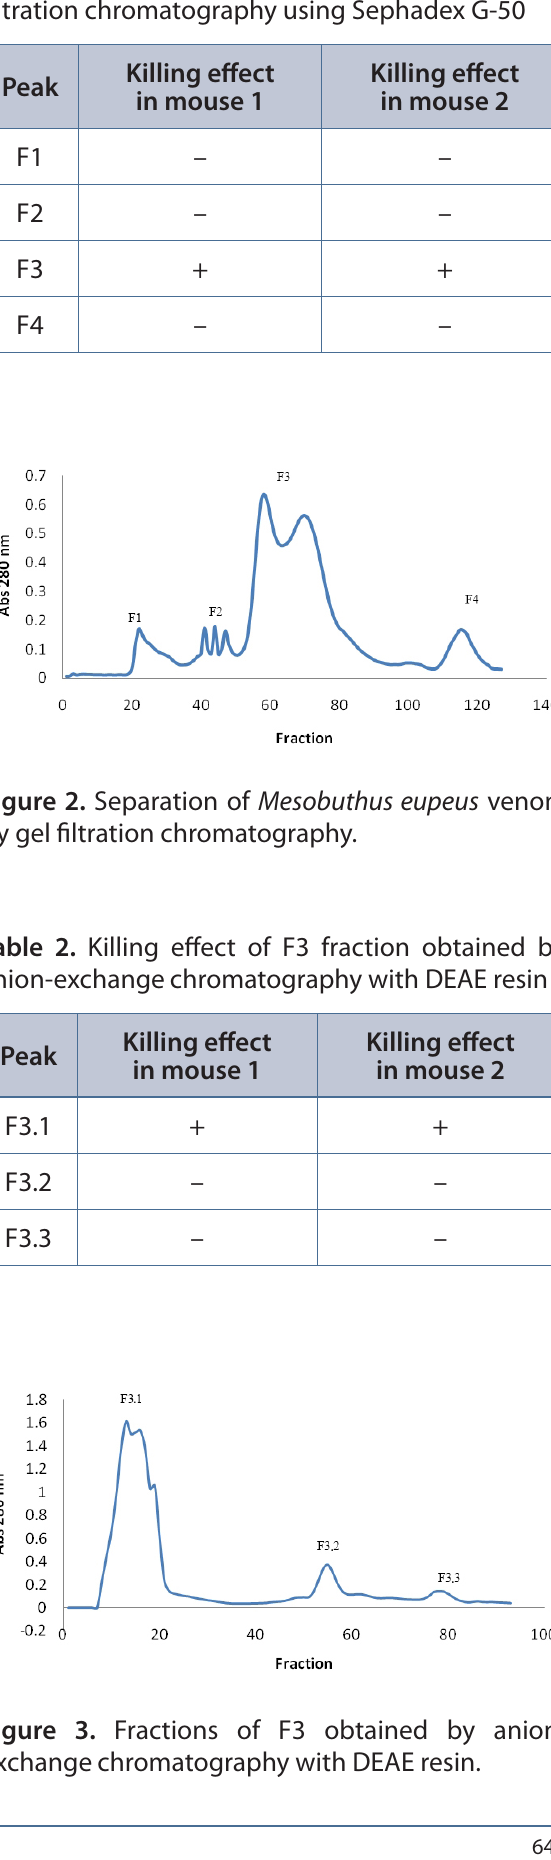
Table1. Killing effect of venom submitted to gel-